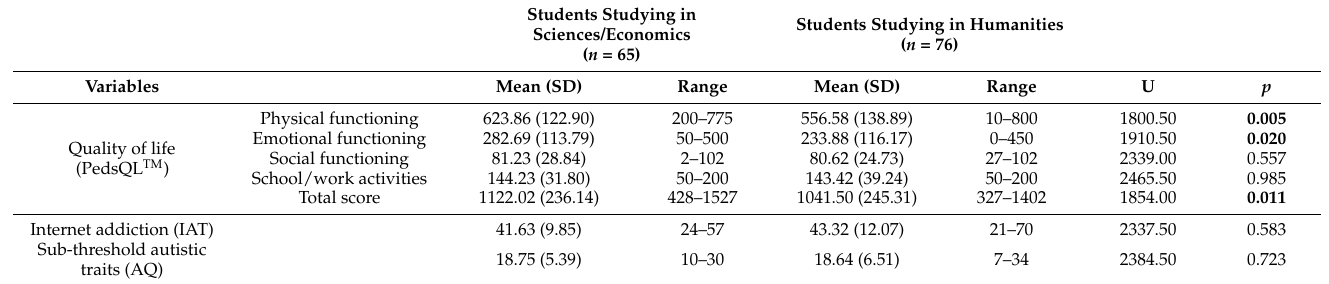
Table 2. Descriptive data for quality of life (PedsQL TM ), Internet addiction (IAT) and sub-threshold autistic traits (AQ) by major area, and results of the statistical comparisons (Mann–Whitney tests). Significant results are reported in